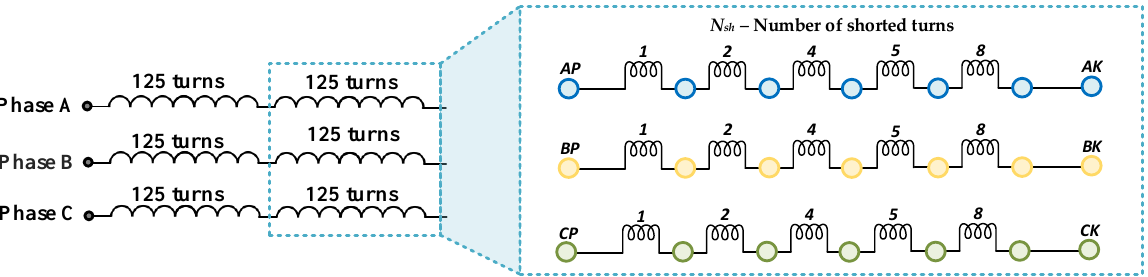
Figure 5. Schematic diagram of the PMSM stator winding phase terminals.